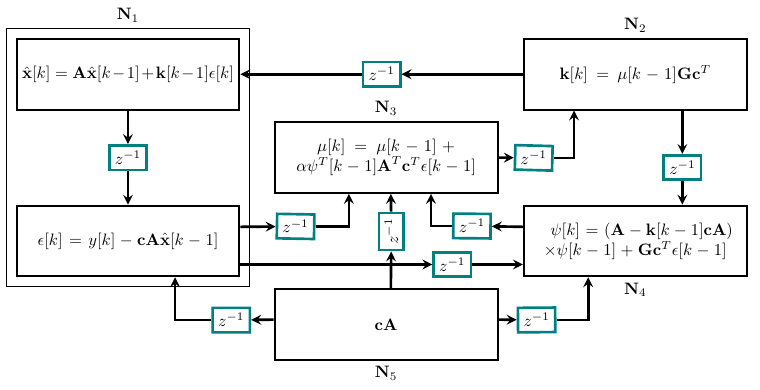
Figure 2. The proposed parallel distributed architecture for the SSLMSWAM adaptive filter.